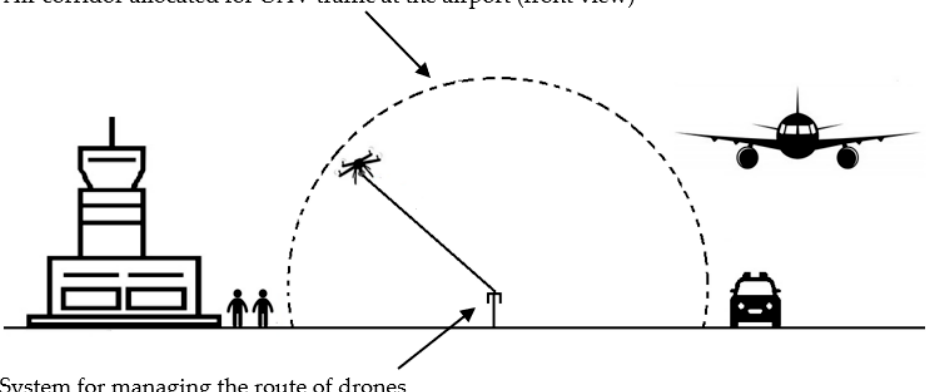
Figure 3. Scheme for ensuring the safety of EM traffic by allocating a separate air corridor and applying the system for managing the route of drones.